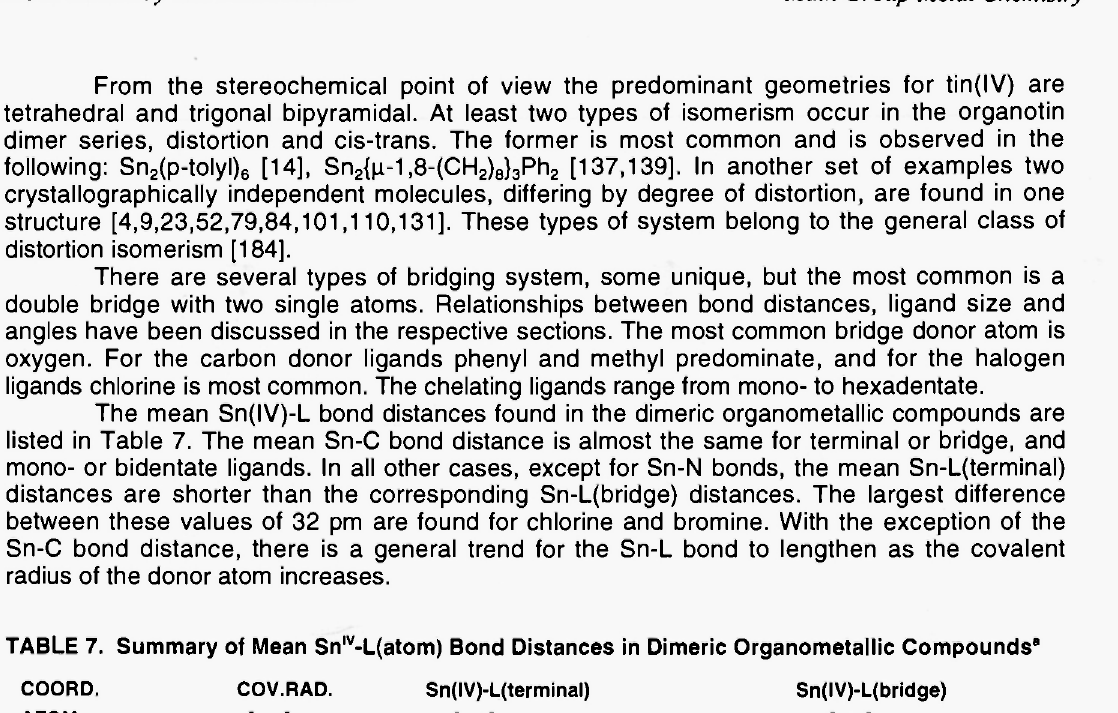
TABLE 7. Summary of Mean Sn' v -L(atom) Bond Distances in Dimeric Organometallic Compounds" COORD.